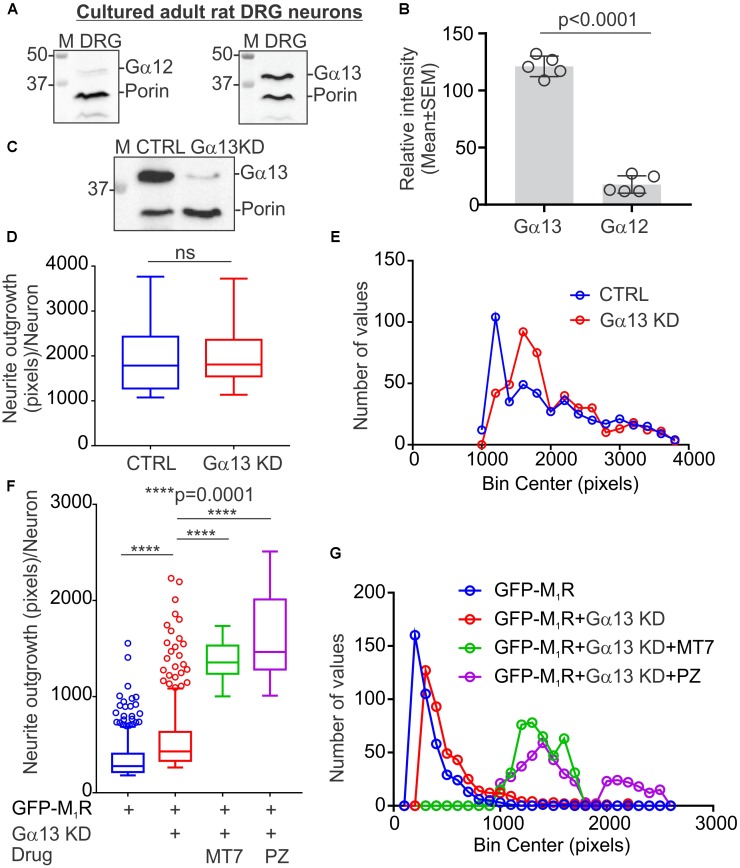
Knockdown of Gα13 reversed M1R overexpression-induced inhibition of neurite outgrowth. (A) Immunoblots showing relative expression of Gα12 and Gα13 proteins in cultured DRG neurons. (B) Scatter plot showing relative amount of Gα12 and Gα13 proteins in cultured sensory neurons. N = 5 independent experiments. p-value was calculated by unpaired t-test. (C) Immunoblots showing siRNA (cocktail of 3 siRNAs targeted to rat Gα) based knockdown of Gα13 protein in cultured adult rat DRG neurons. (D,F) Whisker box (Tukey) showing total neurite outgrowth per neuron. DRG neurons were transfected with a pEFGP-C1-M1R plasmid and siRNA using Amaxa nucleofection reagent and allowed to grow for 48 h. Scrambled siRNAs were used for control. In drug treatment groups, neurons were cultured in media supplemented with 100 nM MT7 or 1 μM pirenzepine following transfection. The neurons were fixed after 48 h of culture, stained with β-tubulin III and imaged using Cellomics ArrayScan HCS Reader. p-value by unpaired t-test or one-way ANOVA test followed by Dunnett’s multiple comparisons tests. N = 432/452 (in D) and 406/694 (in F). (E,G) Binning of the entire data set presented in (D,F).